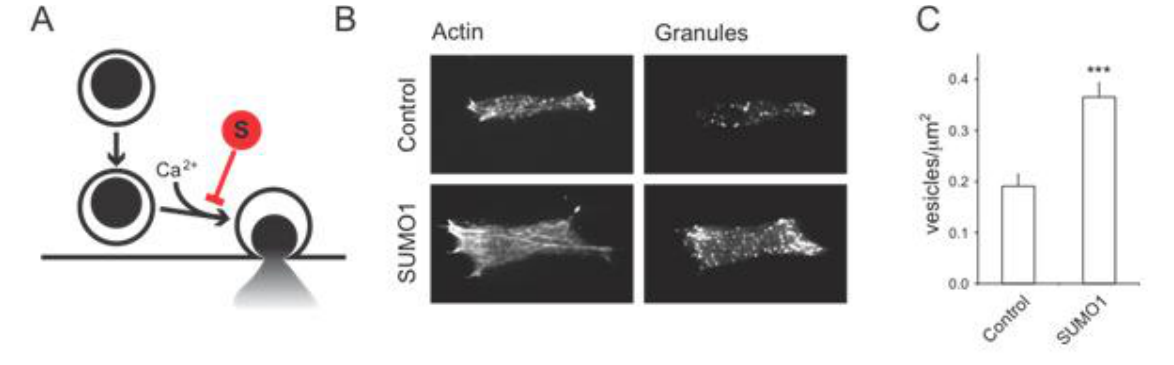
Figure 2. SUMOylation inhibits the exocytosis of secretory granules, without affecting granule trafficking to the plasma membrane. ( A ) SUMOylation (S) acts downstream of insulin granule targeting to the plasma membrane to inhibit Ca 2+ -dependent exocytosis. Up-regulating SUMO1 blocks downstream exocytosis and results in a build-up of secretory granules at the plasma membrane. This can be seen by total-internal reflection fluorescence (TIRF) imaging of cortical actin and secretory granules labeled with NPY-mCherry within ~100 nm of the plasma membrane. Representative images are shown in ( B ), and quantified data is shown in ( C ). *** p < 0.001 compared with